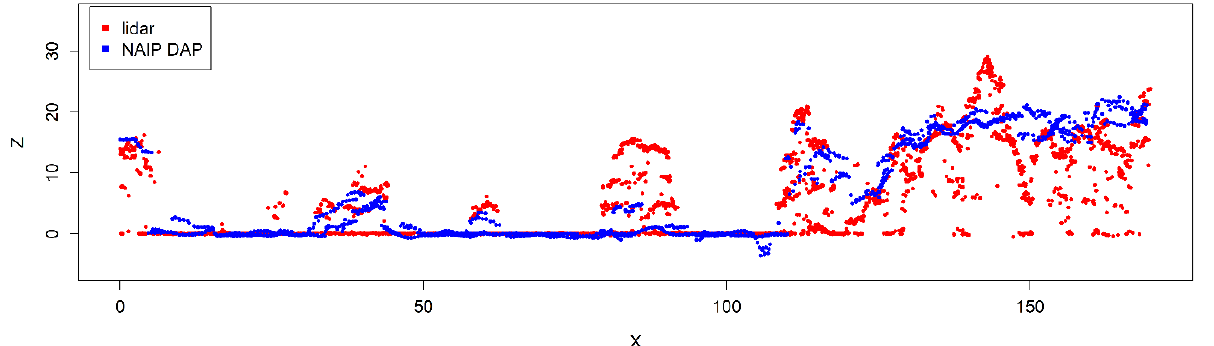
Figure 3. Comparison of pushbroom NAIP DAP point cloud (red) and lidar point cloud (blue) heights above lidar DTM for a 1 m wide 170 m long strip, where the tallest tree is approximately 30 m according to the lidar.